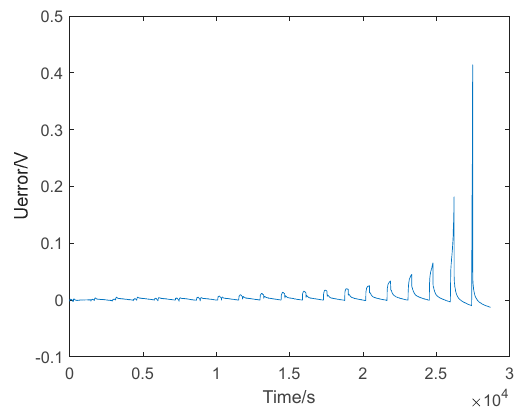
Figure 8. The error of the voltage prediction curves .